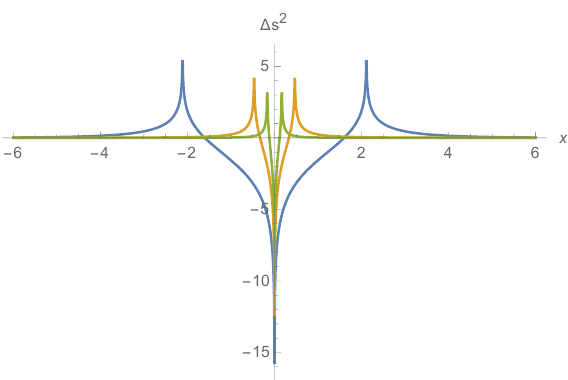
Figure 10. Real part of ∆ S (2) as a function for different components of the field strength. Blue A line: α = 5 , α 0 = 25 ; orange line α = 10 , α 0 = 30 ; green line α = 15 , α 0 = 35